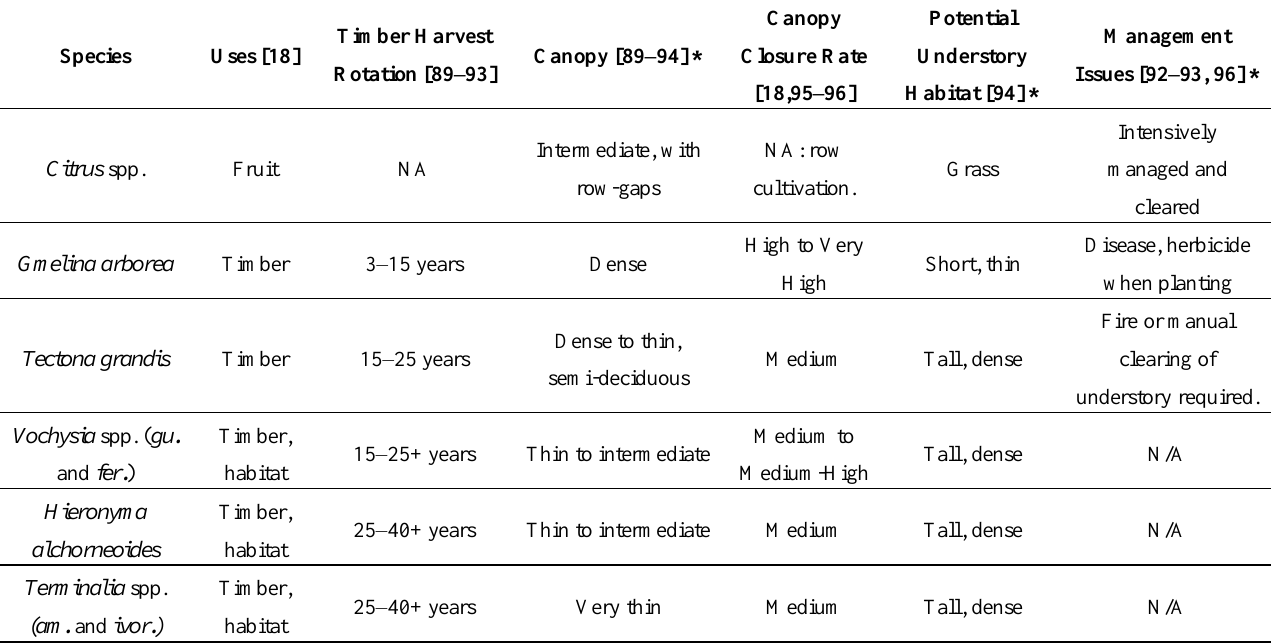
Table 1. Characteristics of the selected tree plantation species in this study. The first three species ( Citrus spp., G. arborea , and T. grandis ) are non-native, while the rest are native tree species. Three of the groups (referred to as species for simplicity) were actually genera, with species combined because of low sample sizes: Citrus spp. (species unknown), Vochysia spp. ( guatemalensis and ferruginea ), and Terminalia spp. ( amazonia and ivorensis ).